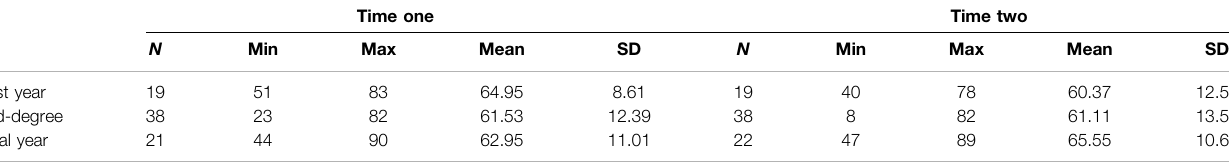
TABLE 7 | PWI scores summary Time One and Time Two.